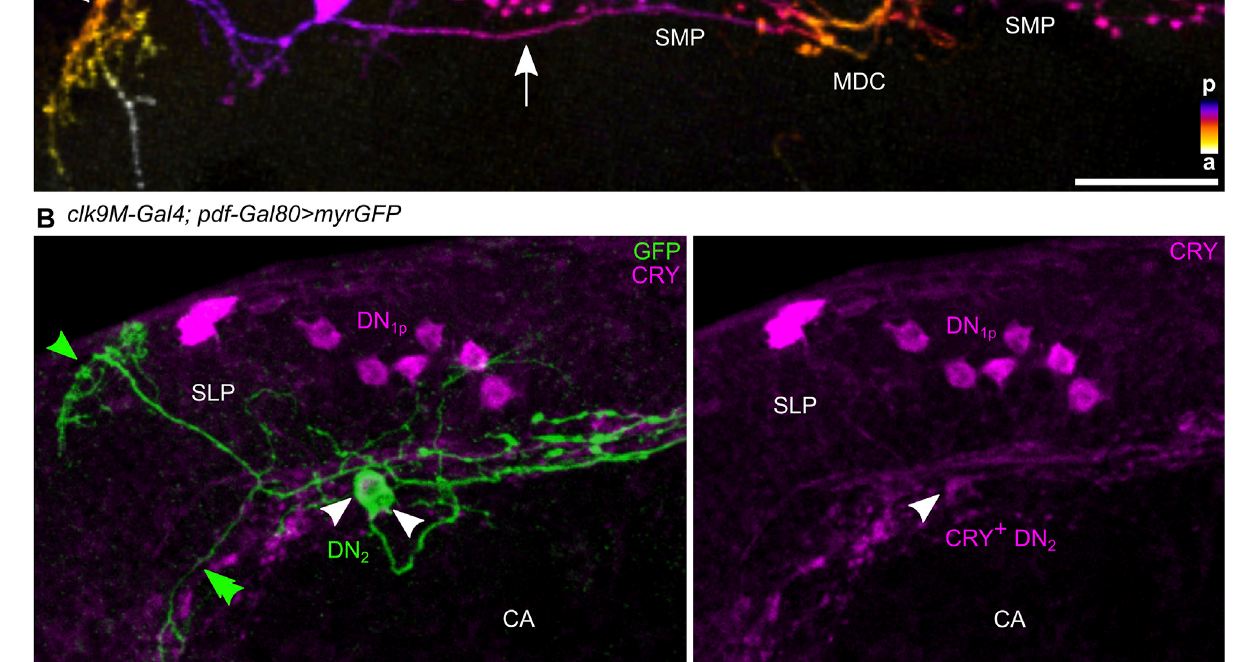
FIGURE 10 | The morphology of the DN 2 s. (A) Maximal projection of 20 confocal planes showing a frontal view of the dorsal protocerebrum, in which one DN 2 is marked with cytosolic GFP using the split-GAL4 line R43D03-AD; VT003234 with the 20xUAS-6xGFP reporter) and counter-stained with anti-CRY (magenta) and anti- PDF (cyan). The lower panel shows the GFP labeling of the area marked above in greater detail in color-coded depth information. Fibers in the posterior (p) brain are marked blue and fi bers further anterior (a) are marked in yellow/white. (B) Maximal projection of 26 confocal planes showing a frontal view of the left dorsolateral protocerebrum, in which two DN 2 s are marked with membrane-bound GFP (using Clk9M-GAL4; Pdf-GAL80 with the UAS-myrGFP reporter) and counter-stained with anti-CRY (magenta). Note that one of the two DN 2 s is weakly CRY-positive (CRY + DN 2 , right). Green arrowheads mark the DN 2 fi bers projecting to the anterior optic